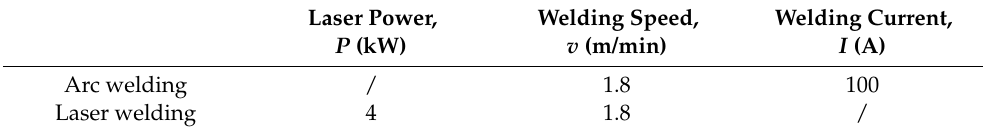
Figure 1. Experimental setup for laser-arc hybrid welding. Table 2. Welding parameters for arc welding and laser welding.